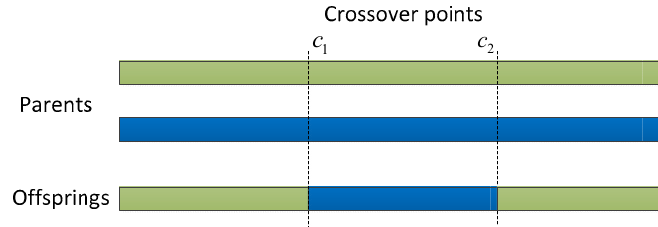
Figure 2. Two-point crossover operation.